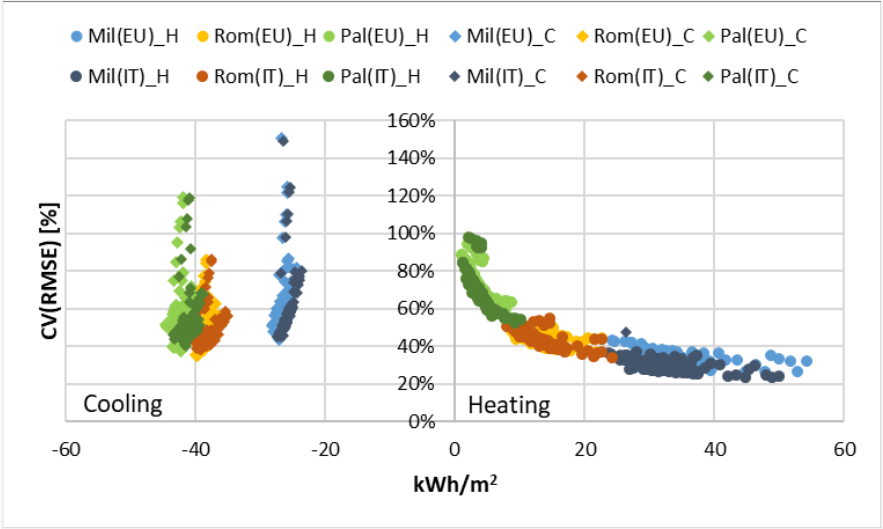
Figure 7. CV(RMSE) for heating and cooling needs, for all climates of the case study and for both methods (EU: Annex B, IT: Annex A): Case study with g gl,n = 0.77. Table 7. Minimum, maximum, average and standard deviation value of CV(RMSE) and the RMSE of both methods of EN ISO 52016 (Annex A and Annex B). Case study with g gl,n = 0.77. The gray cells show the best percentages.